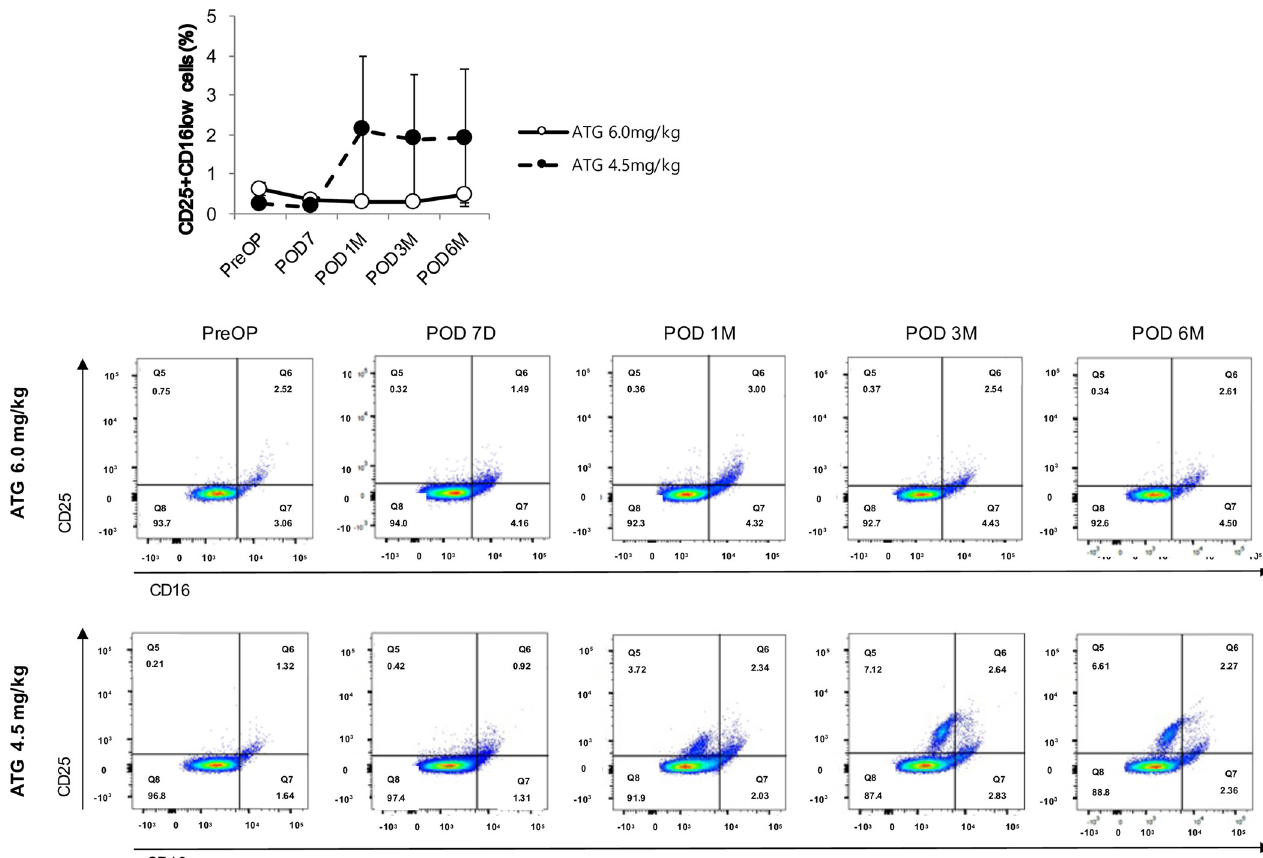
Fig 6. Proportion of CD25 + CD16 low cells among CD3 - CD11b + cells according to the dose of anti-thymocyte globulin. ATG, anti-thymocyte globulin.